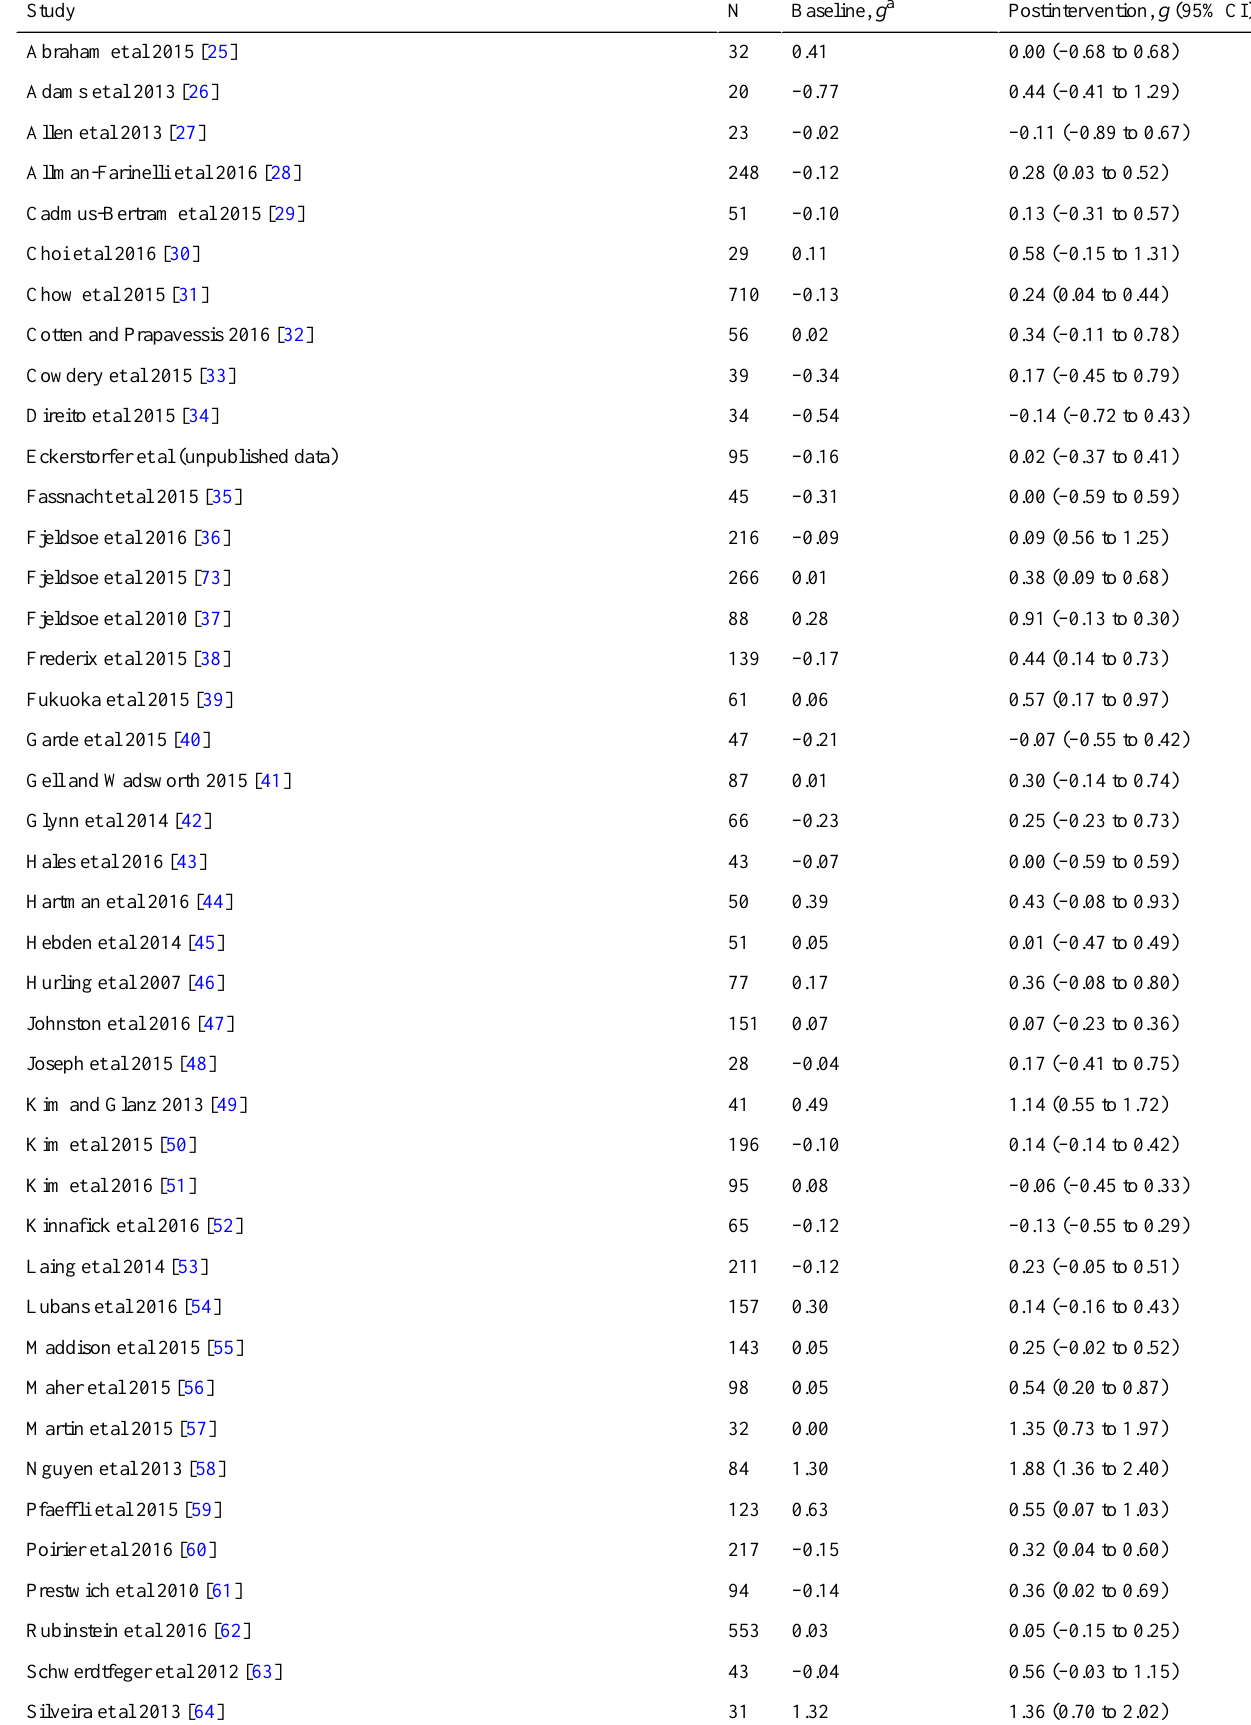
Postintervention, g (95% CI)Baseline, g a